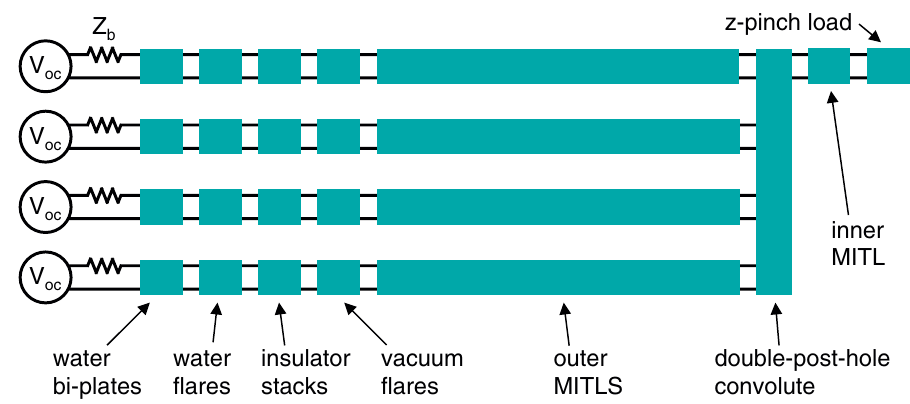
is the open-circuit voltage; oc